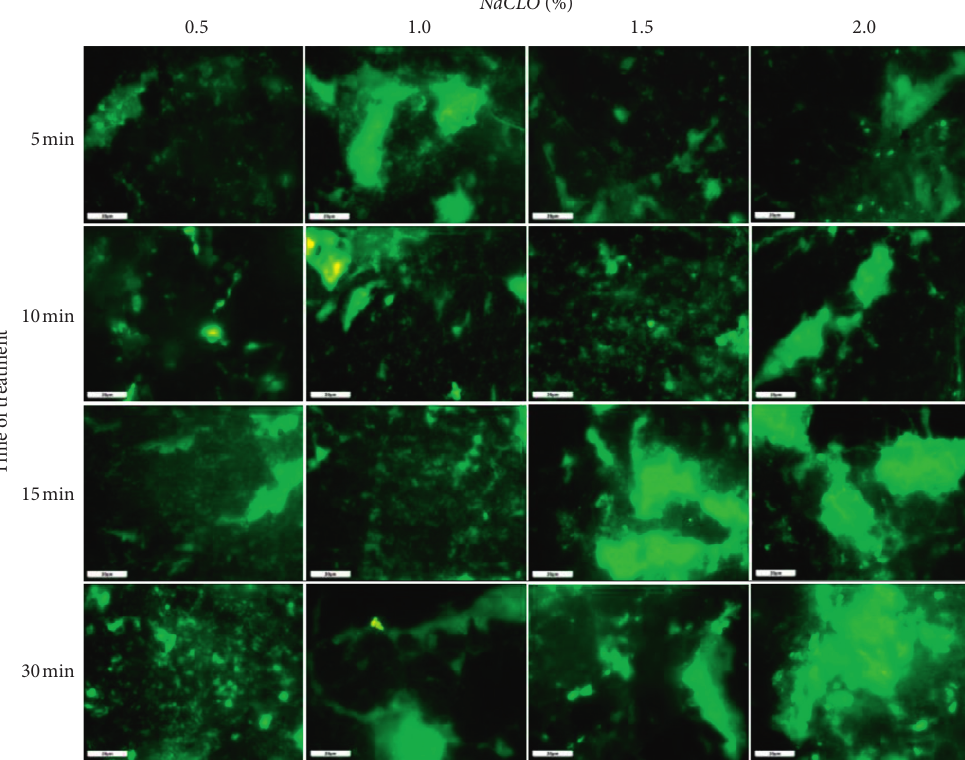
Figure 11: Effectiveness of NaCLO against P. aeruginosa biofilm installed on the granite Gris Pinhel at the concentration of 0.5, 1, 1.5, and 2% after 5, 10, 15, and 30min of treatment.